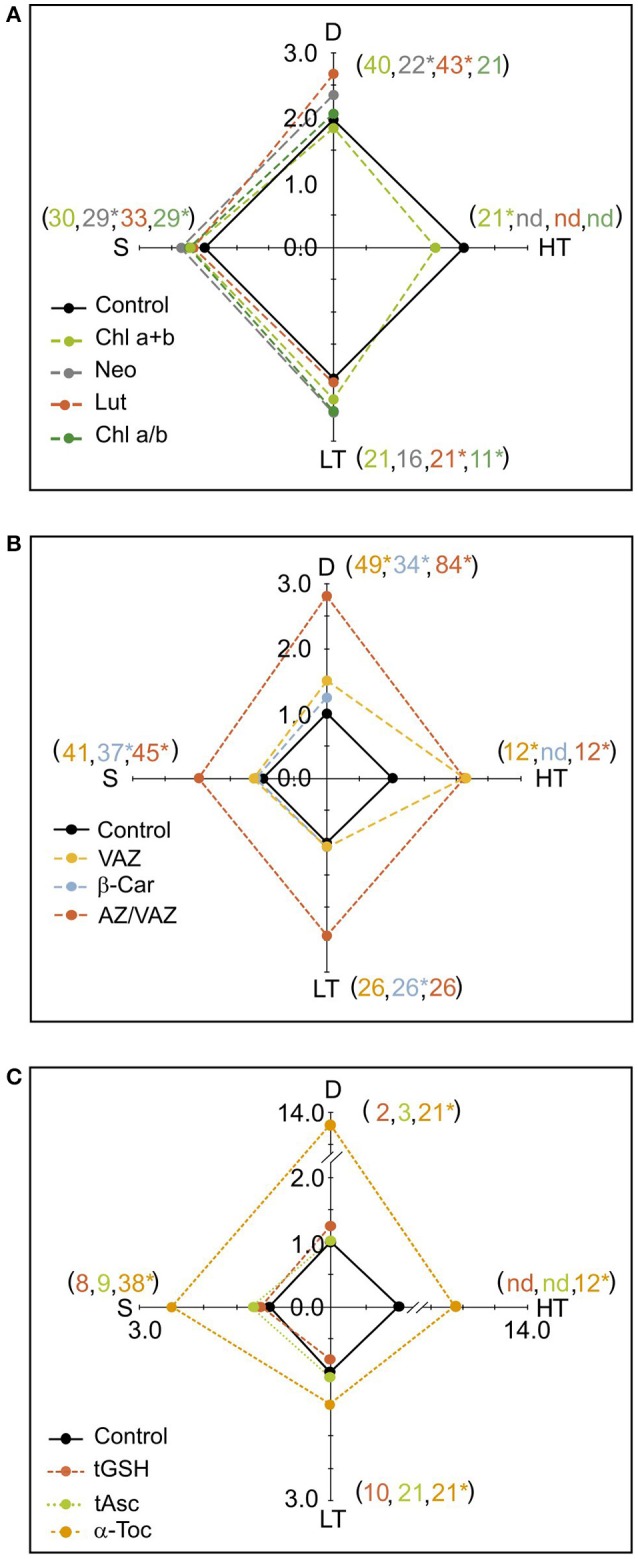
Spiderplots showing the effect of the main stress factors considered in the Mediterranean regions (D, drought; HT, high temperature; LT, low temperature; S; Seasonality) on photosynthetic pigments and antioxidants. (A) Photosynthetic pigments: chlorophylls and structural xanthophylls Neo and Lut. (B) Photosynthetic pigments: V-cycle xanthophyls and b-Car. (C) Free antioxidants: tGSH, tASC and a-Toc. Units are as in Figure 1, except for tGSH (here shown in μmol g−1 DW). For each stress factor, every data was normalized to its respective control within each manuscript of origin (controls were values cataloged as “control” in the original papers). Thus, value 1 indicates the control in the boxplots, while the deviation from 1 indicates the impact of the stress on the parameters analyzed. For more details see material and methods. Shown data are means of several cases. The number of cases used for each factor and compound is shown in brackets. Note that the color of the number indicates the corresponding metabolite. SE is not shown for clarity, but was <6% of the mean in all cases except from α-Toc, for which SE < 10%. Asterisks denote significant differences from control (P < 0.05).